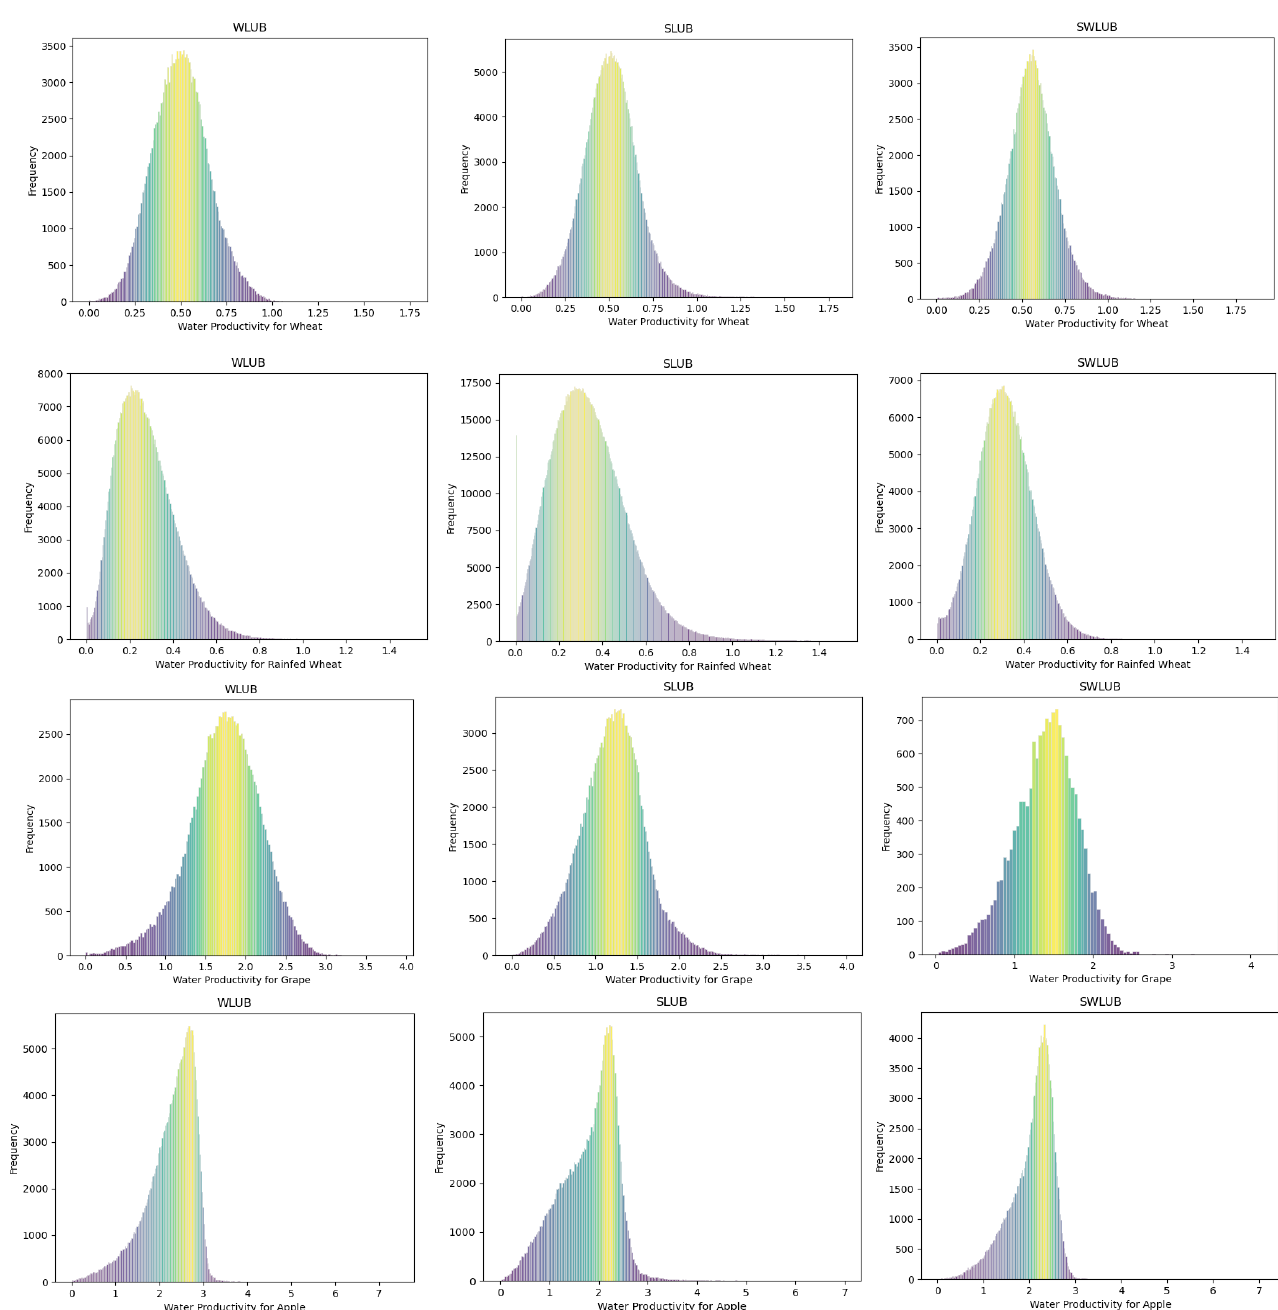
Figure 11. Frequency distribution of WP for irrigated wheat, rainfed wheat, apples, and grapes in LUB. To show the spatial variability of the yield, we constructed box-plots, which are shown in Figure 12. For irrigated and rainfed wheat, the crop yield varies by up to 8 and 3 kg/ha, respectively, with the SWLUB having a relatively higher yield. The apples and grapes in the WLUB show higher variability but are also more productive than the SWLUB and SLUB.